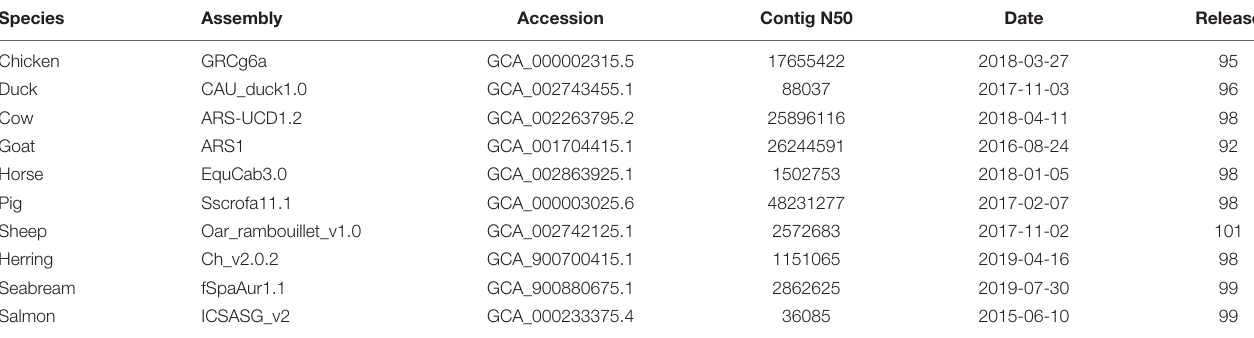
TABLE 1 | Assembly statistics for ten reference livestock species in Ensembl.